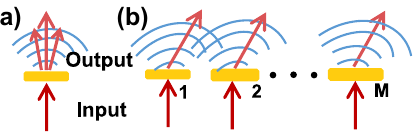
Figure 1: Sketch for the transformation of photon states by the single nano-antenna (a) and periodic supercell with M antennas (b). In (b), each antenna has a designed geometric shape providing a desired phase and amplitude configuration to control the path and the polarization degree of freedom of